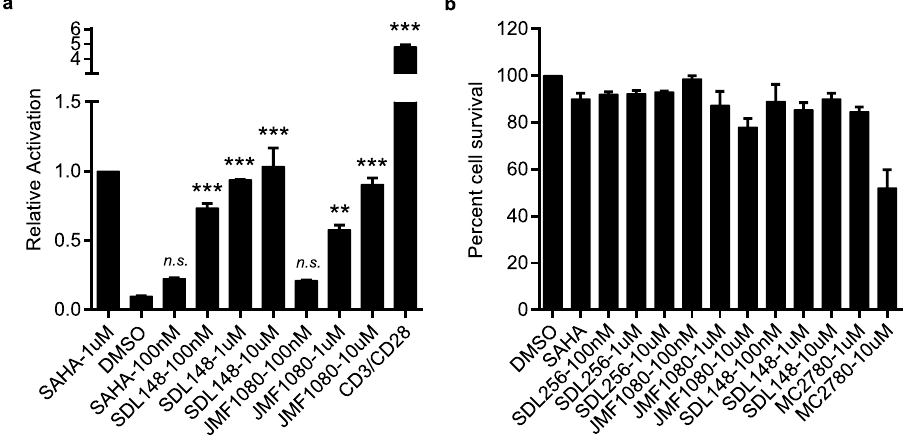
Figure 4. Largazoles induce HIV reactivation in primary cells. ( a ) A primary T-cell model of latency (See text for details). Latently infected T-cells were incubated with the indicated compounds for 48 h. HIV-1 reactivation is presented as fold induction relative to SAHA. Data indicate mean values of experiments in triplicate and error bars indicate mean ± s.e.m. (n ≥ 3). ** p < 0.01, *** p < 0.001 (ANOVA). (b) Toxicity profile of largazoles in primary CD4 + T-cells. Primary resting CD4 + T-cells were incubated with compounds at indicated concentrations for 48 h and MTT toxicity assay performed as described in Methods. Percent cell survival was normalized to